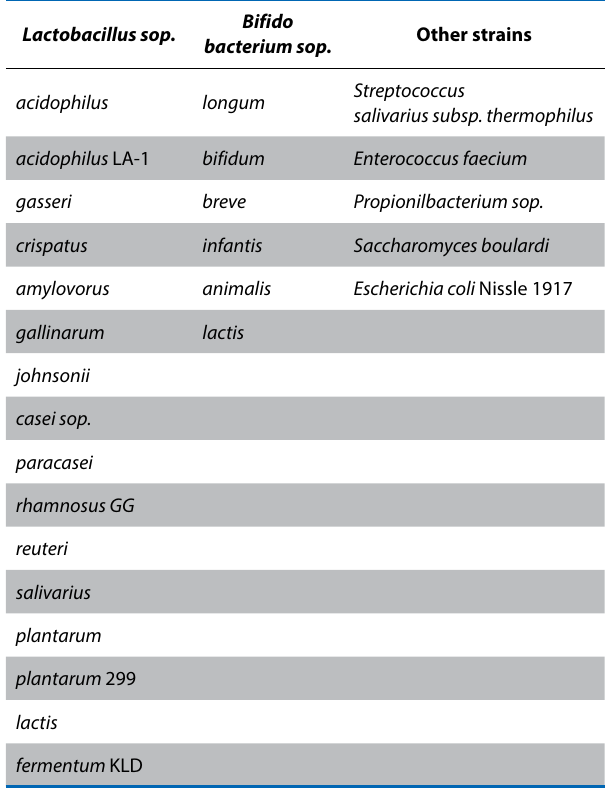
Table 2. Probiotic micro-organisms currently used in probiotic preparations Lactobacillus sop.